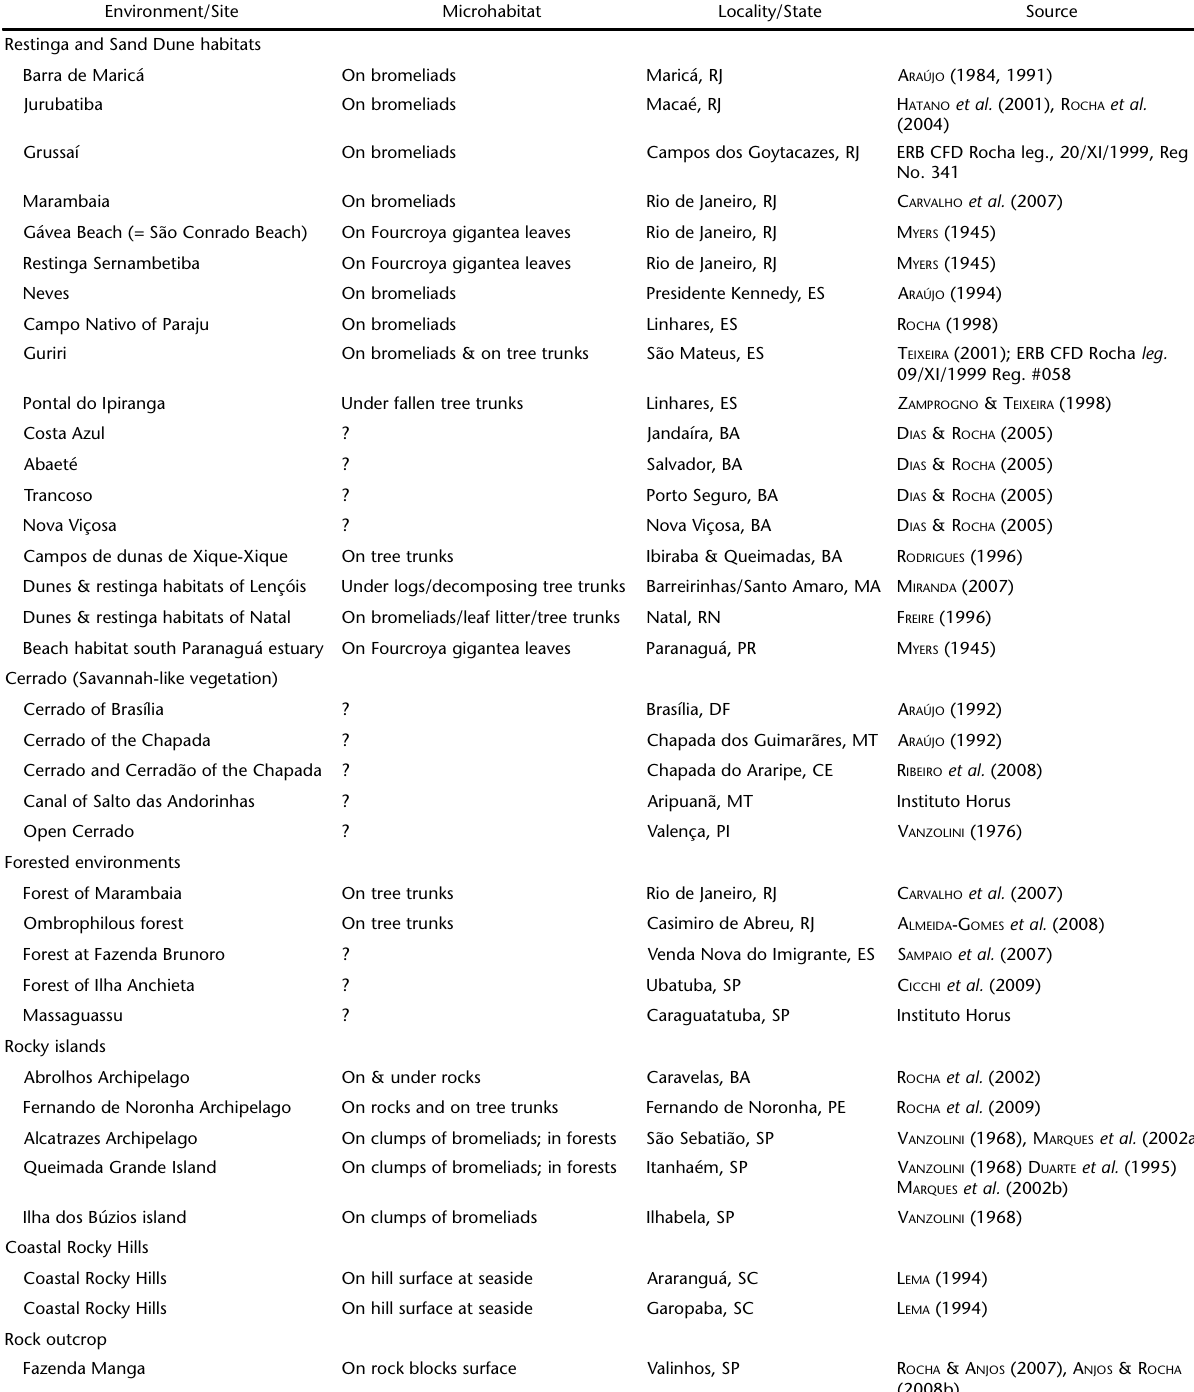
Table I. Summary of the existing literature records of occurrence of the exotic gekkonid lizard Hemidactylus mabouia as an invader species in some natural environments (including locality and State) in Brazil. ERB = Unpublished records of Expedição Restingas Brasileiras Unpublish Record; (?) indicates that information on microhabitat was not